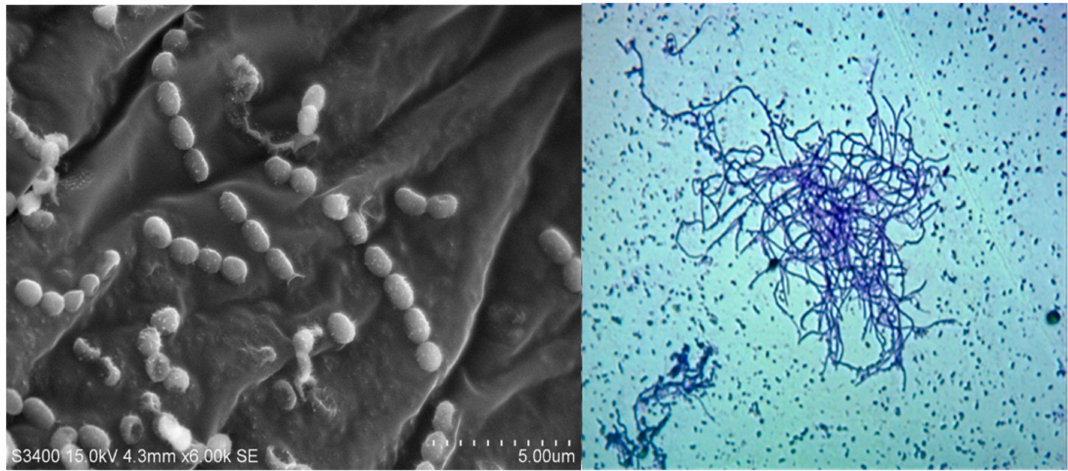
Figure 1. ( A ) Scanning electron micrograph showing spore ornamentation in Streptomyces sp.S2A; ( B ) Microscopic image of Streptomyces sp.S2A under 100 ×